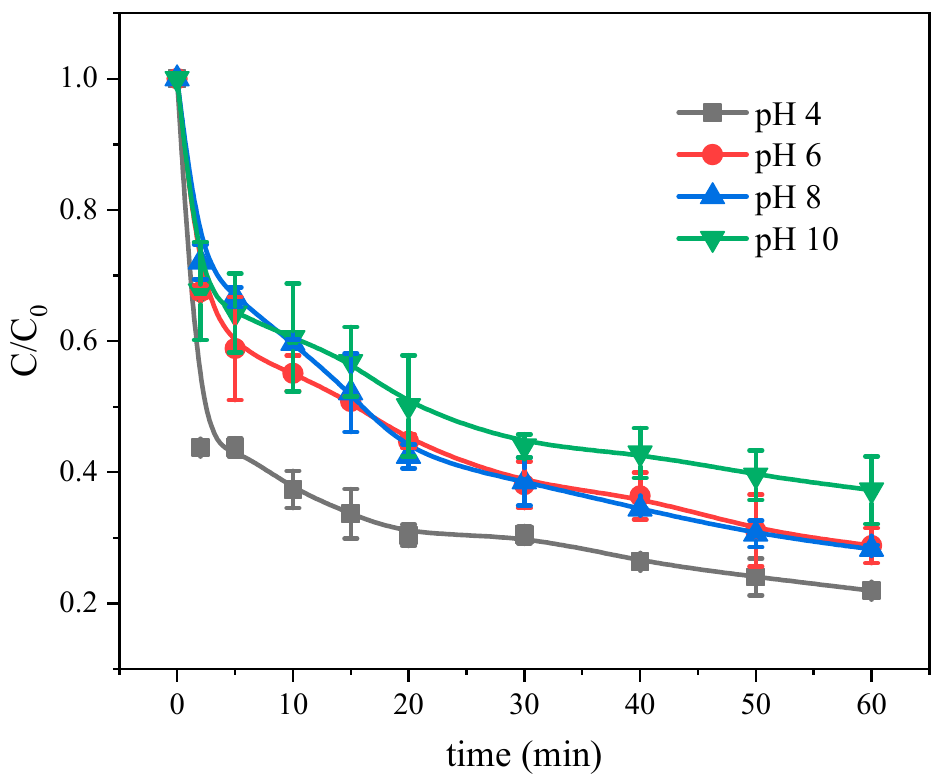
Figure 3. Effect of pH on the Fe(III)-CaSO 3 system. Initial conditions: [Fe(III)] = 0.5 mM, [CaSO 3 ] = 5 mM, [As(III)] = 5 µ M, air bubbling at 0.5 L min − 1 .